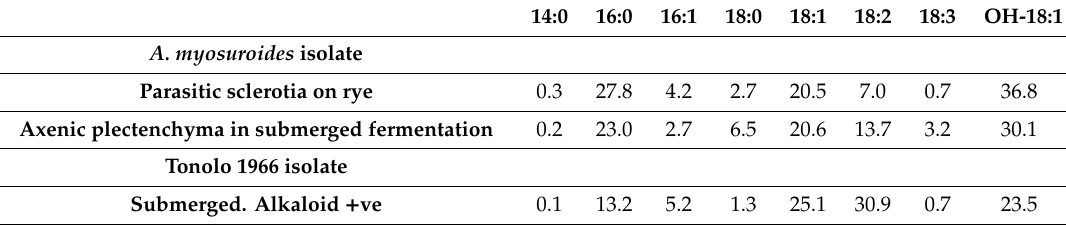
having similar composition in parasitic sclerotia and plectenchymatic mycelium in axenic